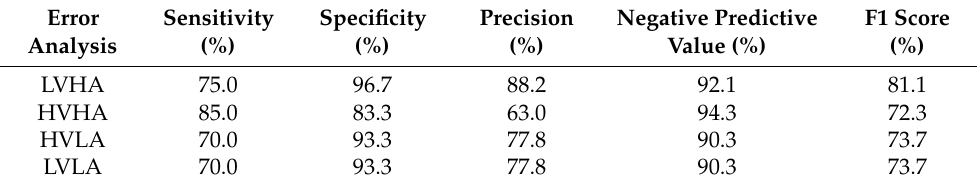
Table 7. The error analysis of results on frontal electrodes except Fp1 and Fp2.